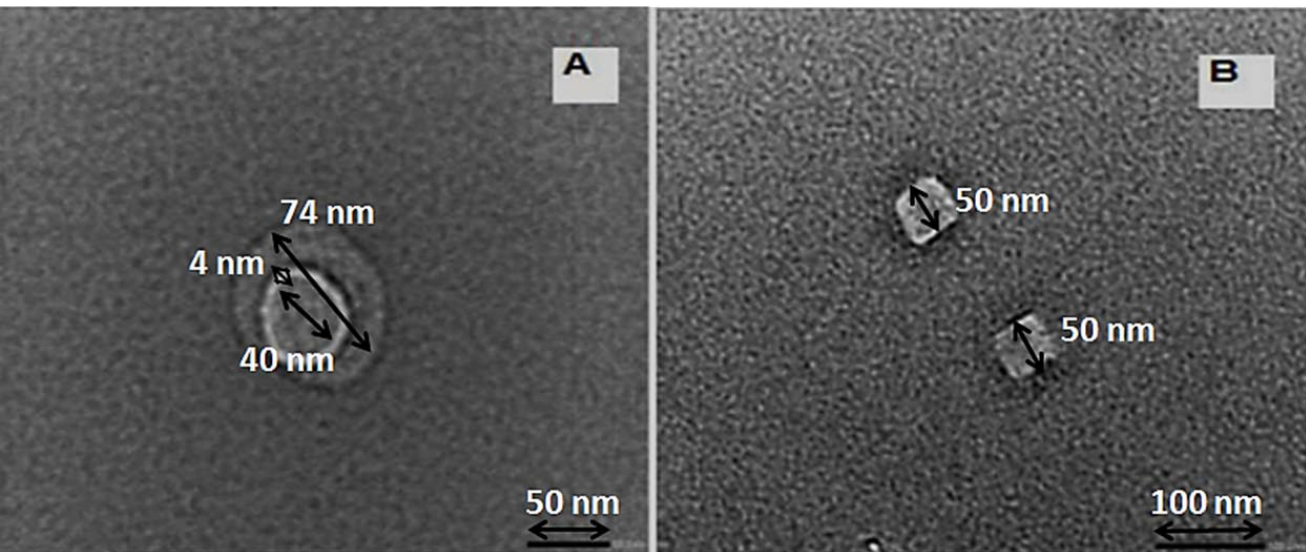
Figure 3. TEM images for NPS and nano porous silica powders in the preparation conditions—7 g of commercial Si powder, 3 wt.% KOH, and at sonication times; ( A ) 3 h, and ( B ) 4